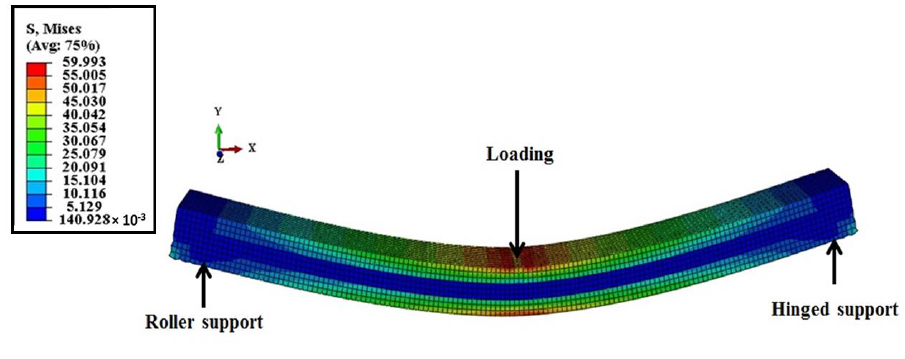
Buildings 2022 , 12 , x FOR PEER REVIEW Figure 7. Deformation and stress distribution in CLT panel using the FEM method.